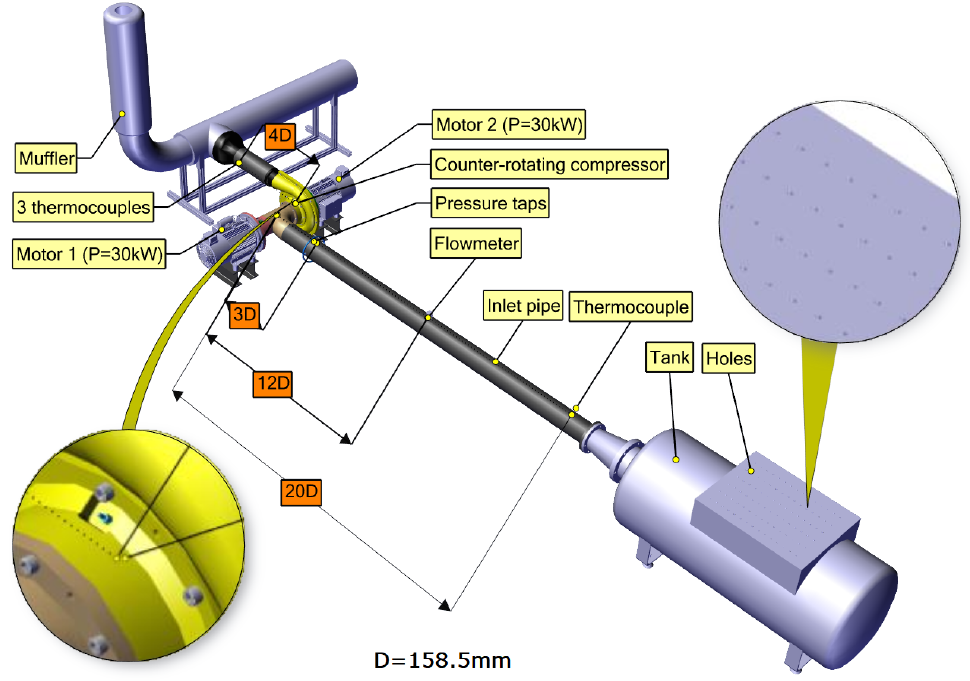
Figure 2. Twin-impeller centrifugal compressor test